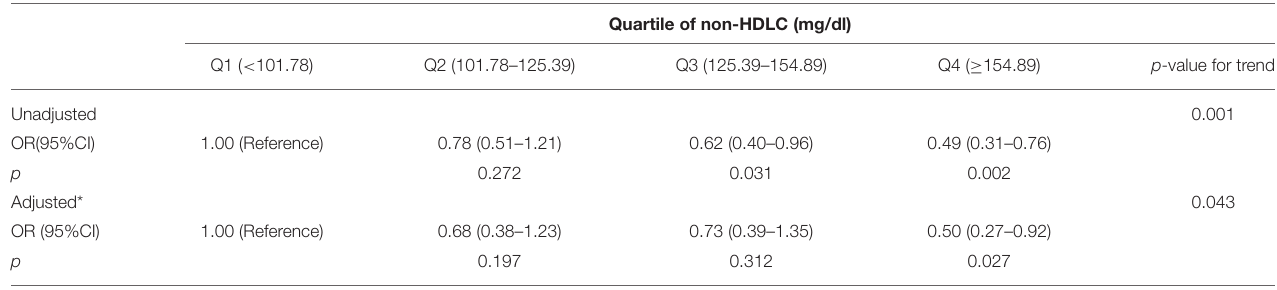
TABLE 2 | Multivariate-adjusted OR and 95% CI for poor outcome (mRS ≥ 3) according to quartile of